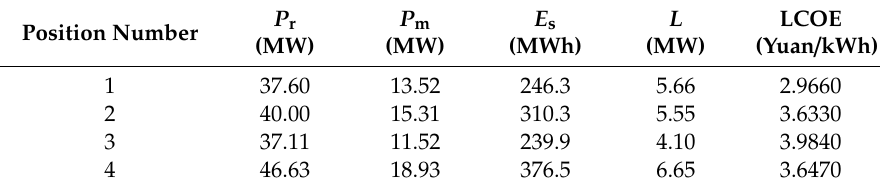
Table 5. Optimal sizing results (2 days continuing the power deficit).